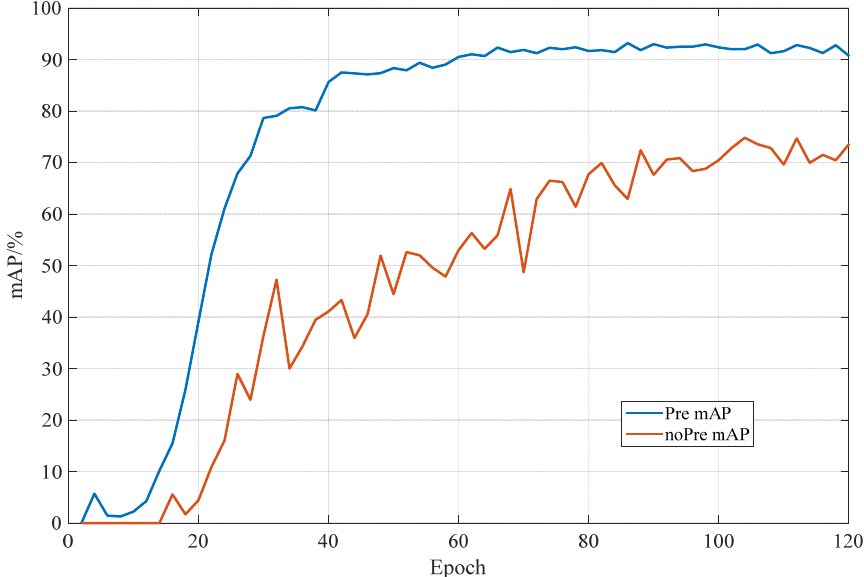
Figure 8. Big coal block dataset training mAP curve.